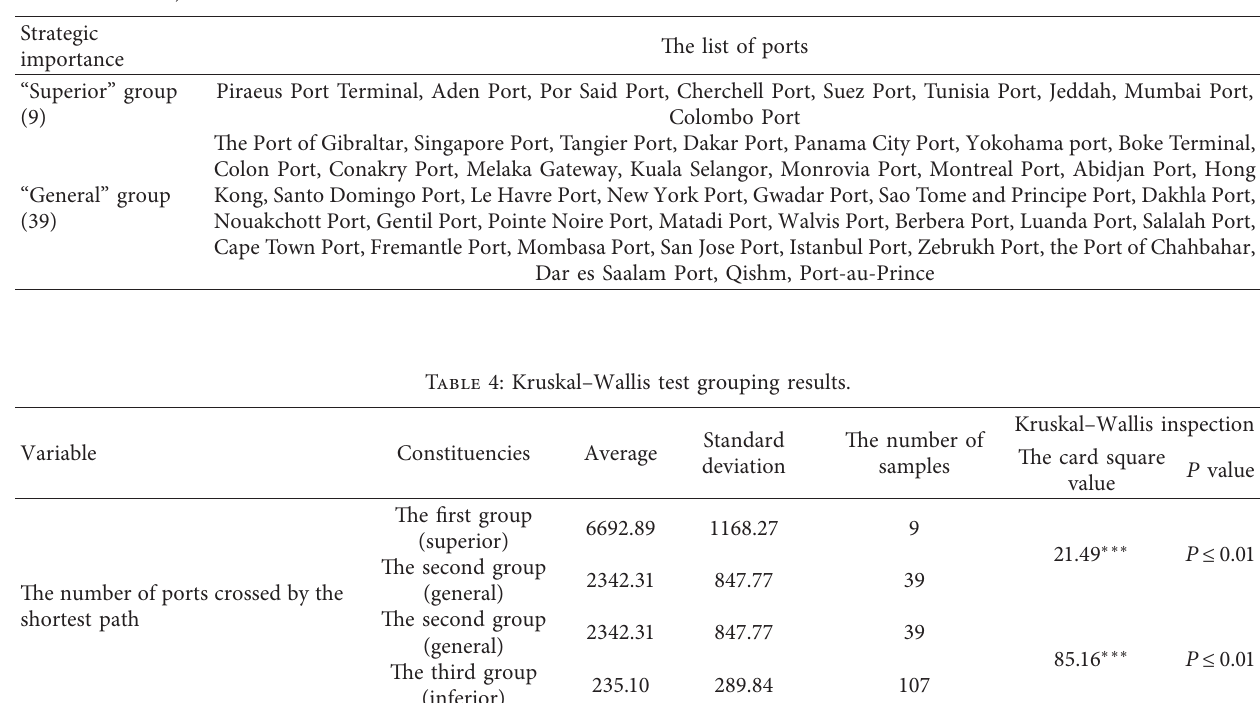
Table 3: The results of the training grouping of the number of ports crossed by the shortest path (ports in the “inferior” group are not listed; specific and available data can be searched or downloaded from the Table Port Betweenness Centrality in the following link: https://doi.org/ 10.4121/14298851).